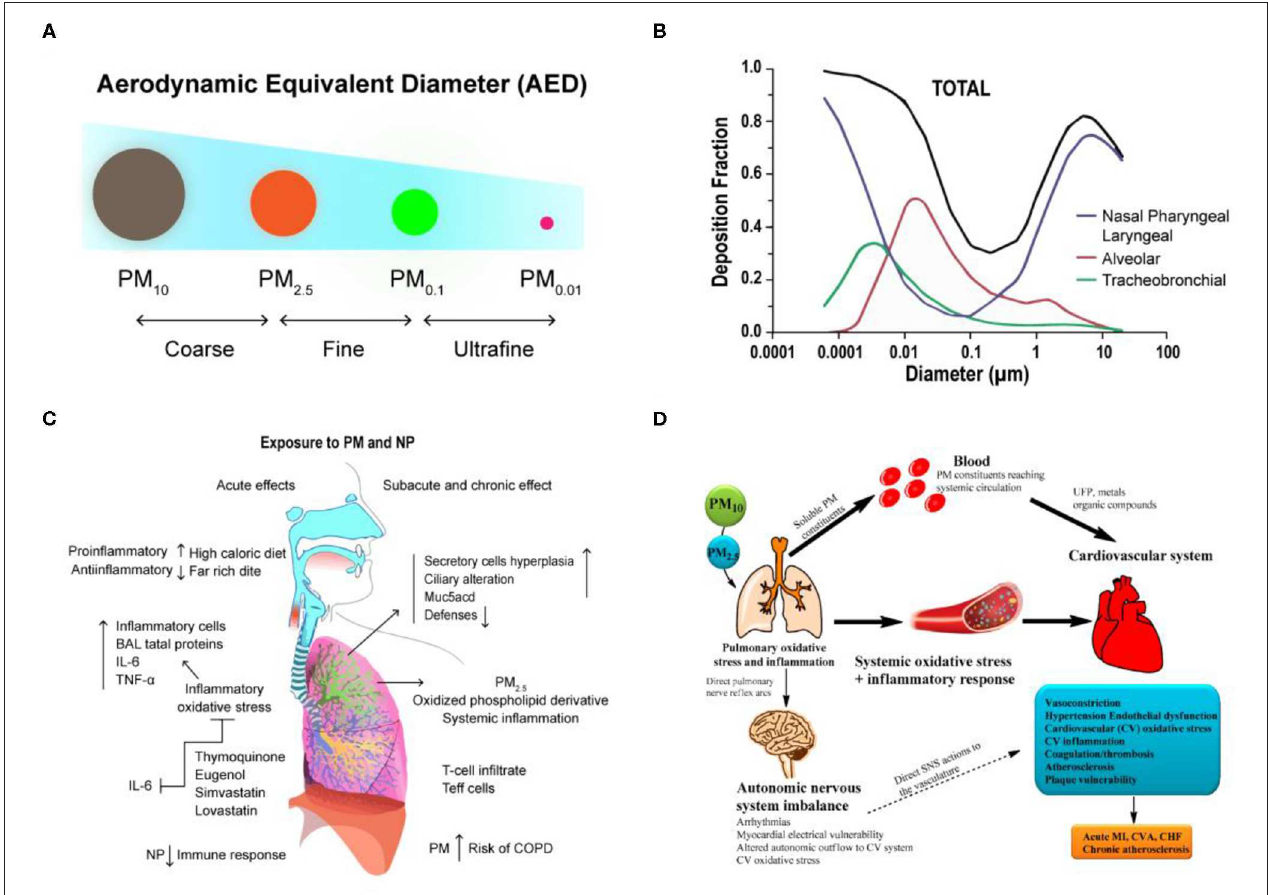
FIGURE 1 | The transport and health effects of PM in human lung and cardiovascular. (A) Classification of PM size by aerodynamic equivalent diameter (AED). (B) PM deposition curves in the extrathoracic, bronchial, and alveolar regions for adult humans. Reproduced with permission from Tsuda et al. (2013). (C) The schematization of the immune responses and inflammation in lung cells by inhaled PM. Reproduced with permission from Nemmar et al. (2013). (D) There are three main hypotheses that PM can cause biological pathways for cardiovascular impairment. Reproduced with permission from Ngoc et al.